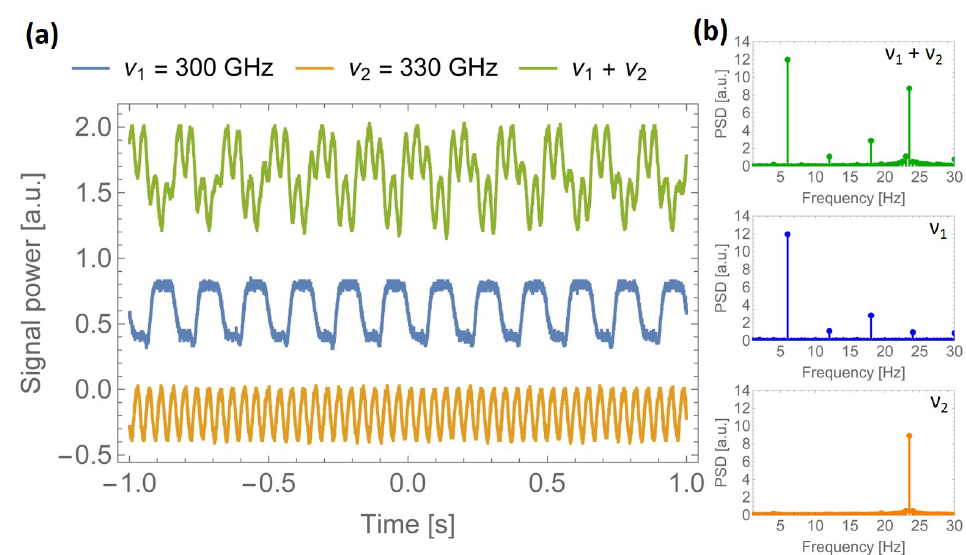
Figure 9. ( a ) Reference results of signals registered in the common path (before DOE). The intensity registered in time domain for frequencies of υ 1 = 300 GHz and υ 2 = 330 GHz with rectangular modulation of ω 1 = 6 Hz and ω 2 = 24 Hz measured in the single optical path before signals separation—both sources are on (green), only a 300 GHz source is on (blue) and only a 330 GHz source is on (orange); ( b ) the power spectral densities for modulated signal frequencies υ 1 and υ 2 obtained by Fourier